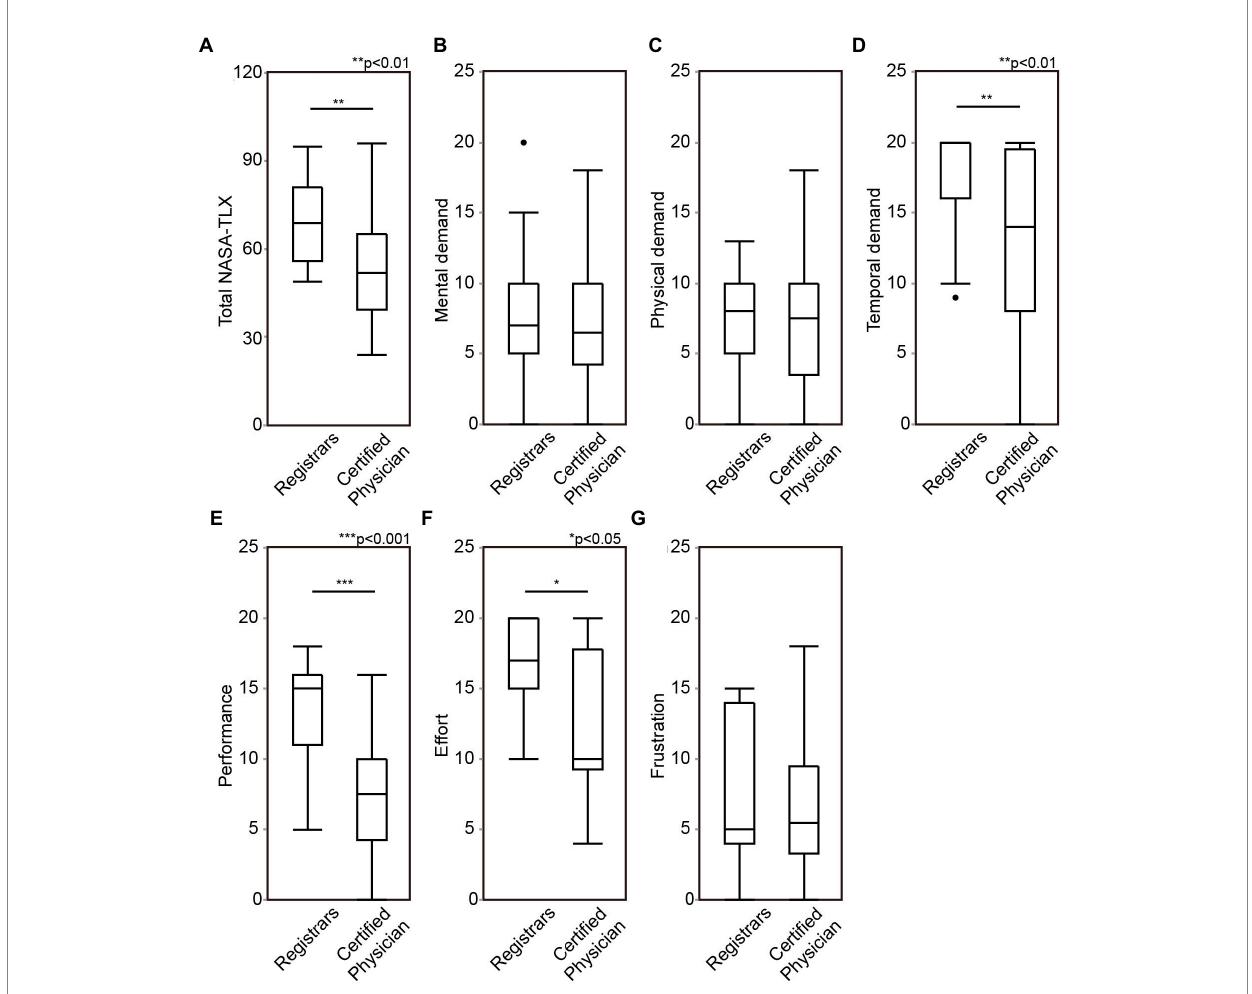
FIGURE 2 Comparison of mental workload during endoscopic sinus surgery (ESS) between otolaryngology registrars and board-certified otolaryngologists. Total score of national aeronautics and space administration-task load index (NASA-TLX) (A) , mental demand (B) , physical demand (C) , temporal demand (D) , performance (E) , effort (F) , and frustration (G) were compared between otolaryngology registrars and board-certified otolaryngologists. ESS, Endoscopic sinus surgeries; NASA-TLX, national aeronautics and space administration-task load index. * p < 0.05, ** p < 0.01, *** p <